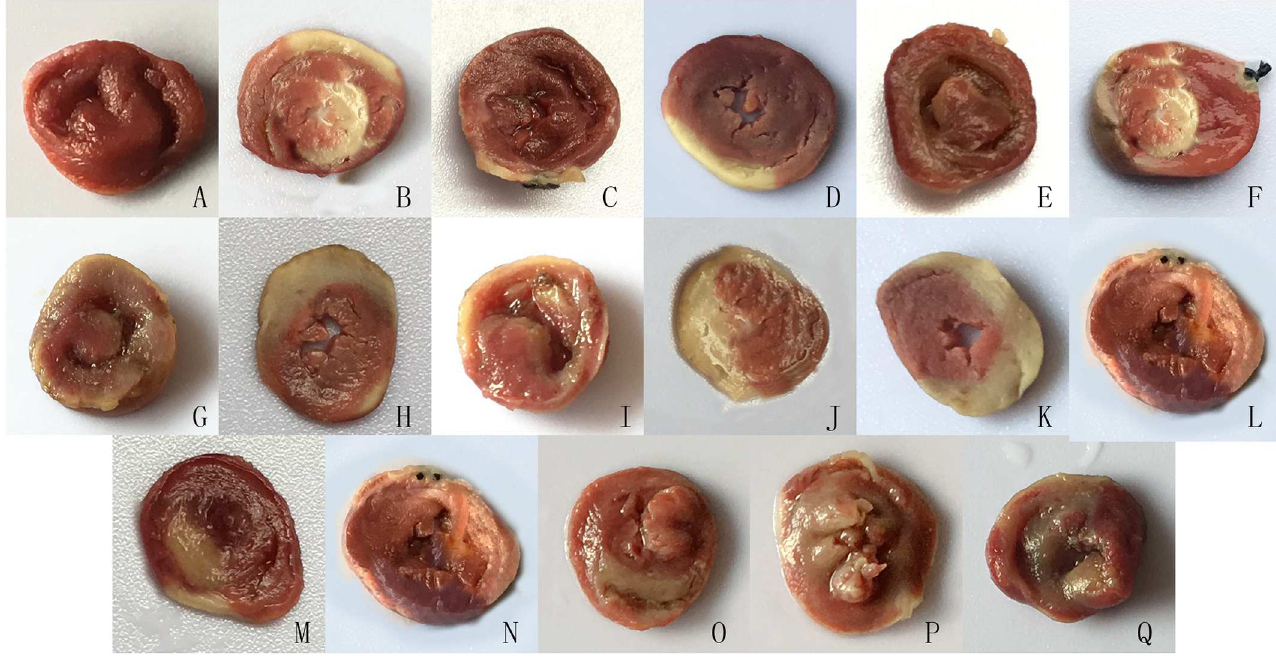
Fig 1. Representative photographs of triphenyltetrazolium chloride (TTC)-stained left ventricular tissue. (A) Sham; (B) I/R, 30 min of ischemiaand 120 min of reperfusion;(C) I/R + ME, moderate intensity exercise for 8 wk before I/R; (D) I/R + HE, high intensity exercise for 8 wk before I/R; (E) I/R + AE, acute exercise before I/R; (F) I/R + ME+ nor-BNI; (G) I/R + HE + nor-BNI; (H) I/R + AE + nor-BNI; (I) I/R + ME + Compound C; (J) I/R + HE + Compound C; (K) I/R + AE + CompoundC; (L) I/R + ME + Akt inhibitor;(M) I/R + HE + Akt inhibitor;(N) I/R + AE + Akt inhibitor;(O) I/R + ME + L-NAME; (P) I/R + HE + L-NAME; (Q) I/R + AE + L-NAME. In each study, nor-BNI (a selective κ -OR antagonist, 2.0 mg/kg), Compound C (an AMPK inhibitor,20 mg/kg), Akt inhibitor (0.3 mg/kg) and L-NAME (an eNOS inhibitor,30 mg/kg) were administered 20min before reperfusion. Left ventriculartissue was then processedand stained with TTC to determine the viable (red) and nonviable(white) myocardium. Infarct sizes were determinedas describedin the Methodssection.